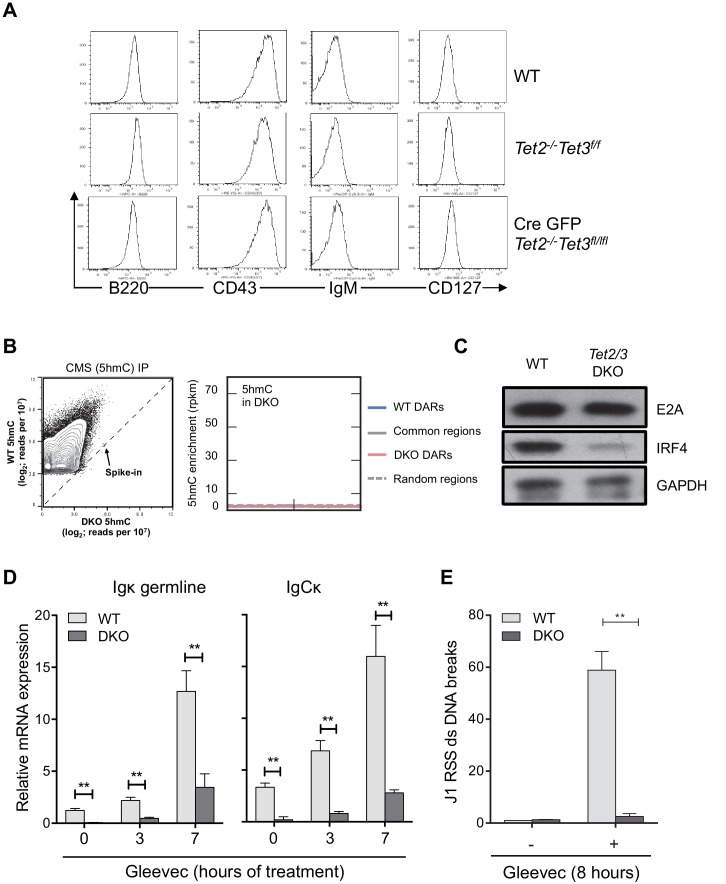
Tet2/3 regulate Igκ expression and rearrangement in BCR-Abl transformed pre-B cells.(A) In vitro-derived WT and Tet2/3 DKO pro-B cells express similar level of pro-B surface markers. Cell-surface expression of B220, CD43, IgM, and CD127 on WT, control (Tet2-/- Tet3f/f) and DKO (Tet2-/- Tet3f/f Cre-GFP) was analyzed by FACS. (B) Right, genome-wide 5hmC distribution in WT and Tet2/3 DKO pro-B cells was mapped as described in Material and Methods. Axes represent the normalized number of reads (reads per 107) in mapped 5hmC-enriched regions combined from WT and Tet2/3 DKO. A PCR-amplified, 5hmC-containing spike-in control was used for normalization between WT and DKO (spike-in). Note that the overall 5hmC level decreased dramatically in the Tet2/3 DKO cells. Level of 5hmC in Tet2/3 DKO pro-B cells across different type of regions was plotted as in Figure 4B. (C) Decreased IRF4 protein in Tet2/3 DKO pro-B cells. The protein level of E2A and IRF4 was determined by immunoblotting with GAPDH as loading control. (D) Decreased Igκ germline transcription in DKO Abl-transformed pre-B cells. BCR-Abl transformed WT and Tet2/3 DKO pre-B cells were treated with Gleevec for 3 or 7 hr and the Igκ germline transcript expression were quantified by qRT-PCR. (E) Recombination of the Igκ locus is greatly diminished in Tet2/3 DKO pre-B cells. Ig light chain rearrangement was induced by Gleevec treatment as in (D) and the induction of DNA double-strand (ds) breaks in the Jκ1 RSS (Recombination Signal Sequence) region was determined by qRT-PCR. The results were normalized to those observed in vehicle (DMSO)-treated cells. The data summarize two independent experiments. **, p<0.01 in student’s t test.